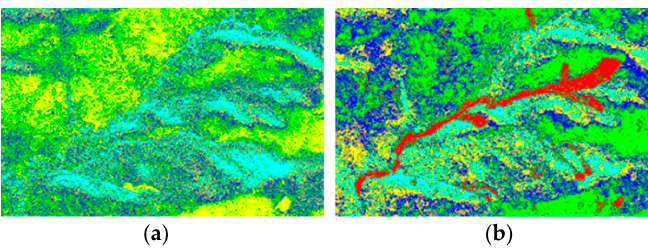
Figure 6. Segmentation results of pre- and post-event images shown in Figure 5 using FCM ( 𝑐 = 5): ( a ) pre-event image, and ( b ) post-event image.